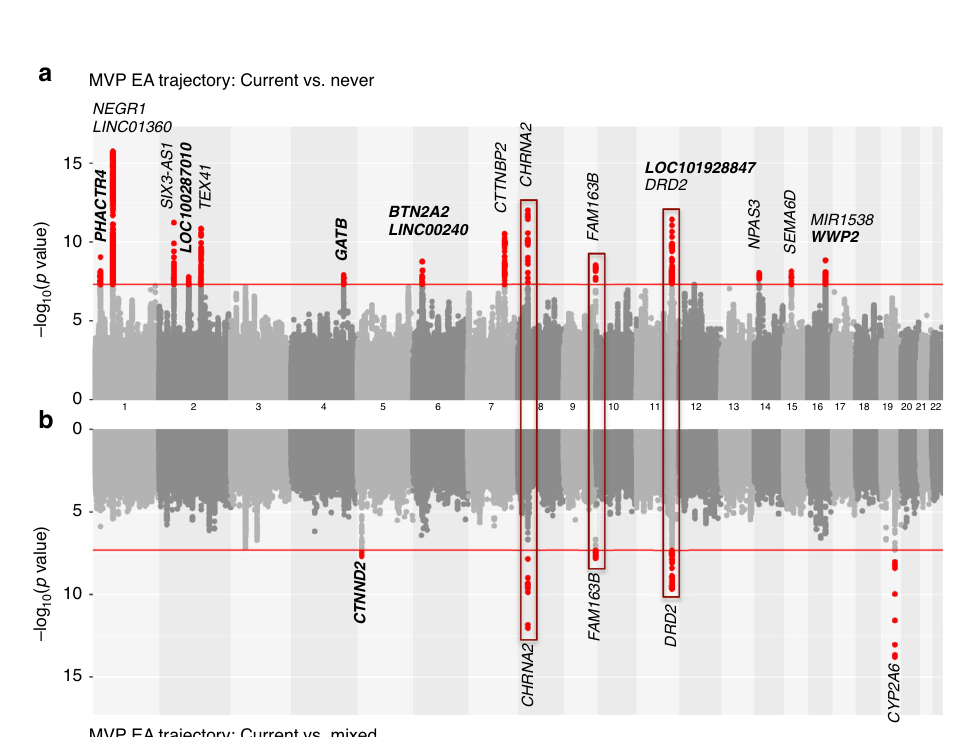
Contrast II (current vs. mixed)